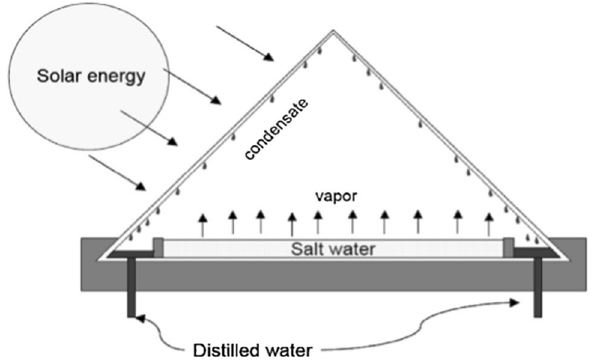
Fig. 26 Solar distiller structure and associated performance (Moh’d A et al.